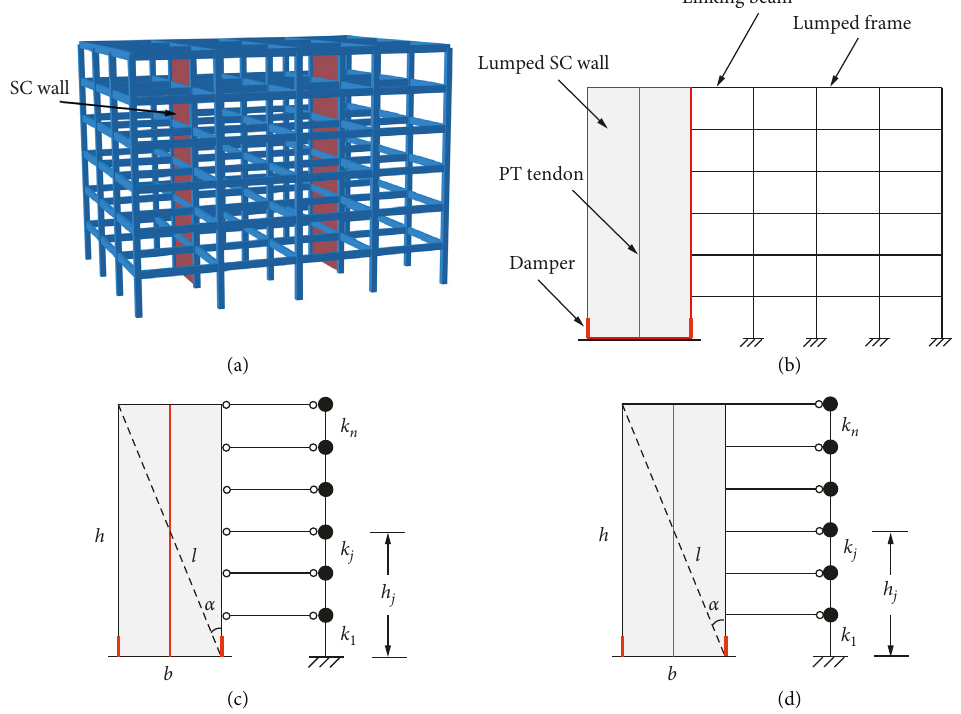
Figure 2: General analysis model of the FSCW structure. (a) 3D view of a typical FSCW structure. (b) 2D representation of a FSCW structure. (c) Pin-jointed system. (d) Rigid-jointed system.